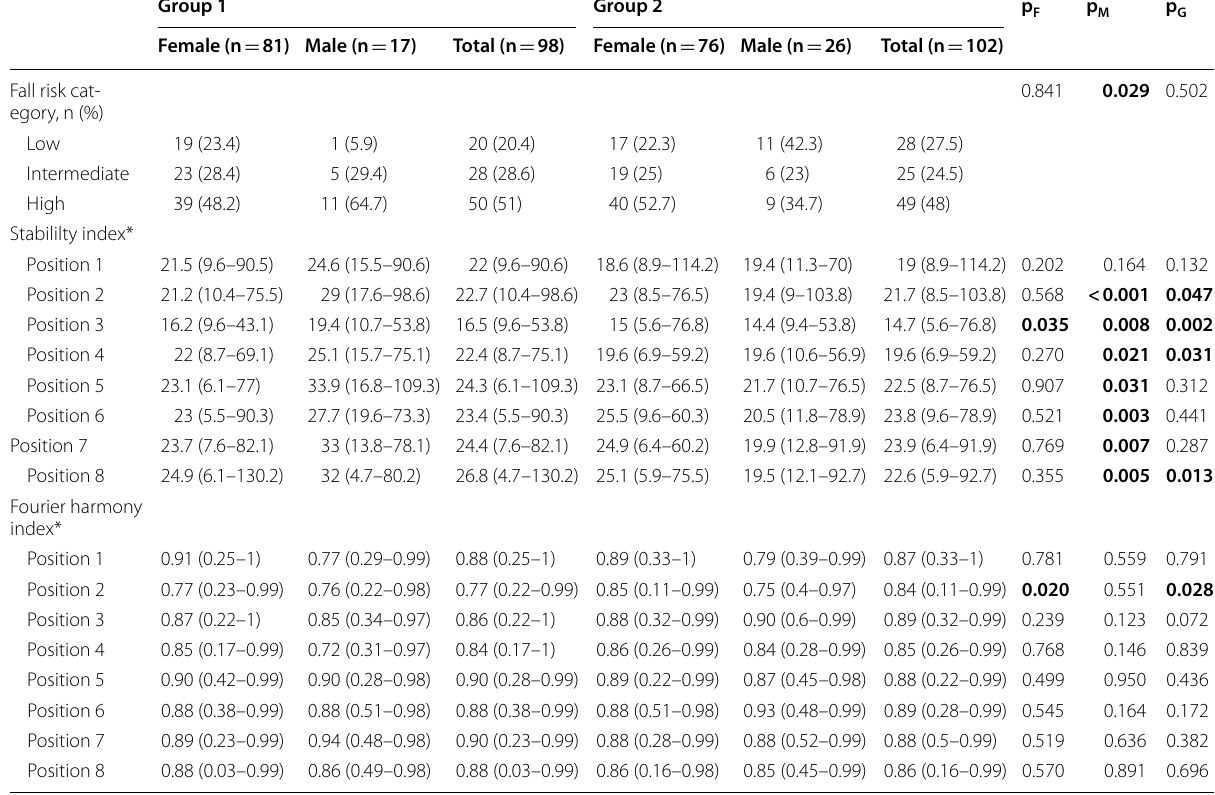
P -value less than 0.05 ( p < 0.05) is statistically significant p F ; significance of difference between females in Group 1 and Group 2. p M ; significance of difference between males in Group 1 and Group 2. p G ; significance of difference between Group 1 and Group 2. Positions: 1, stable surface/eyes open/face forward; 2, stable surface/eyes closed/face forward; 3, unstable surface/eyes open/face forward; 4, unstable surface/eyes closed/face forward; 5, stable surface/eyes closed/head rotated 45° to the right; 6, stable surface/eyes closed/head rotated 45° to the left; 7, stable surface/eyes closed/head tilted back 30°; and 8, stable surface/eyes closed/head tilted 30°